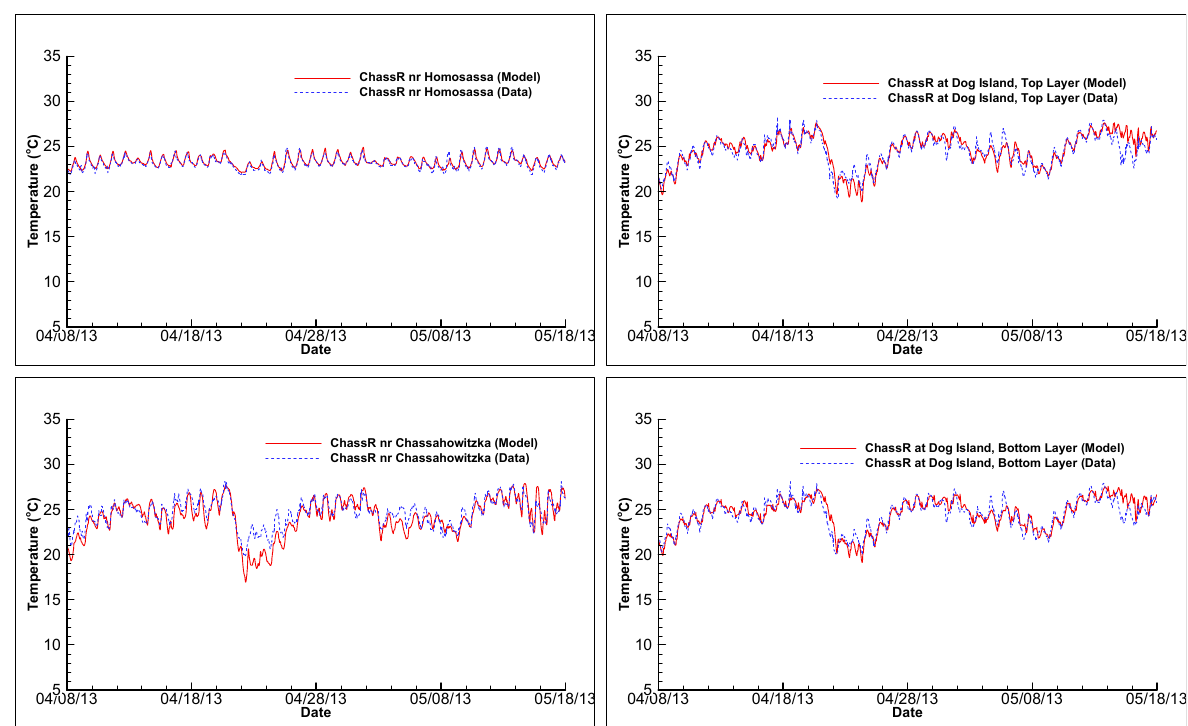
Figure 9. Comparison of measured and simulated temperatures at the CRH ( top left panel), CRC ( bottom left panel), and CRD ( top right panel for top layer, bottom right panel for bottom layer) stations from 8 April 2012 through 18 May 2013.